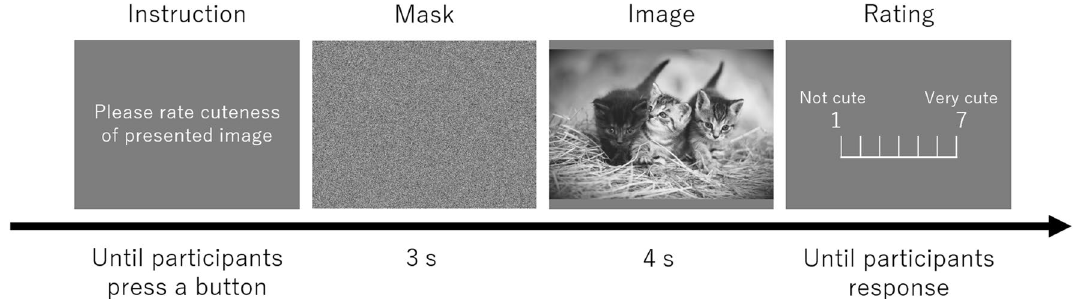
Figure 2. The procedure for a trial. Participants press any response key for rating, and then instruction appears again. Participants had to wait 3 s after pressing a response key and to press a button to start the next trial.